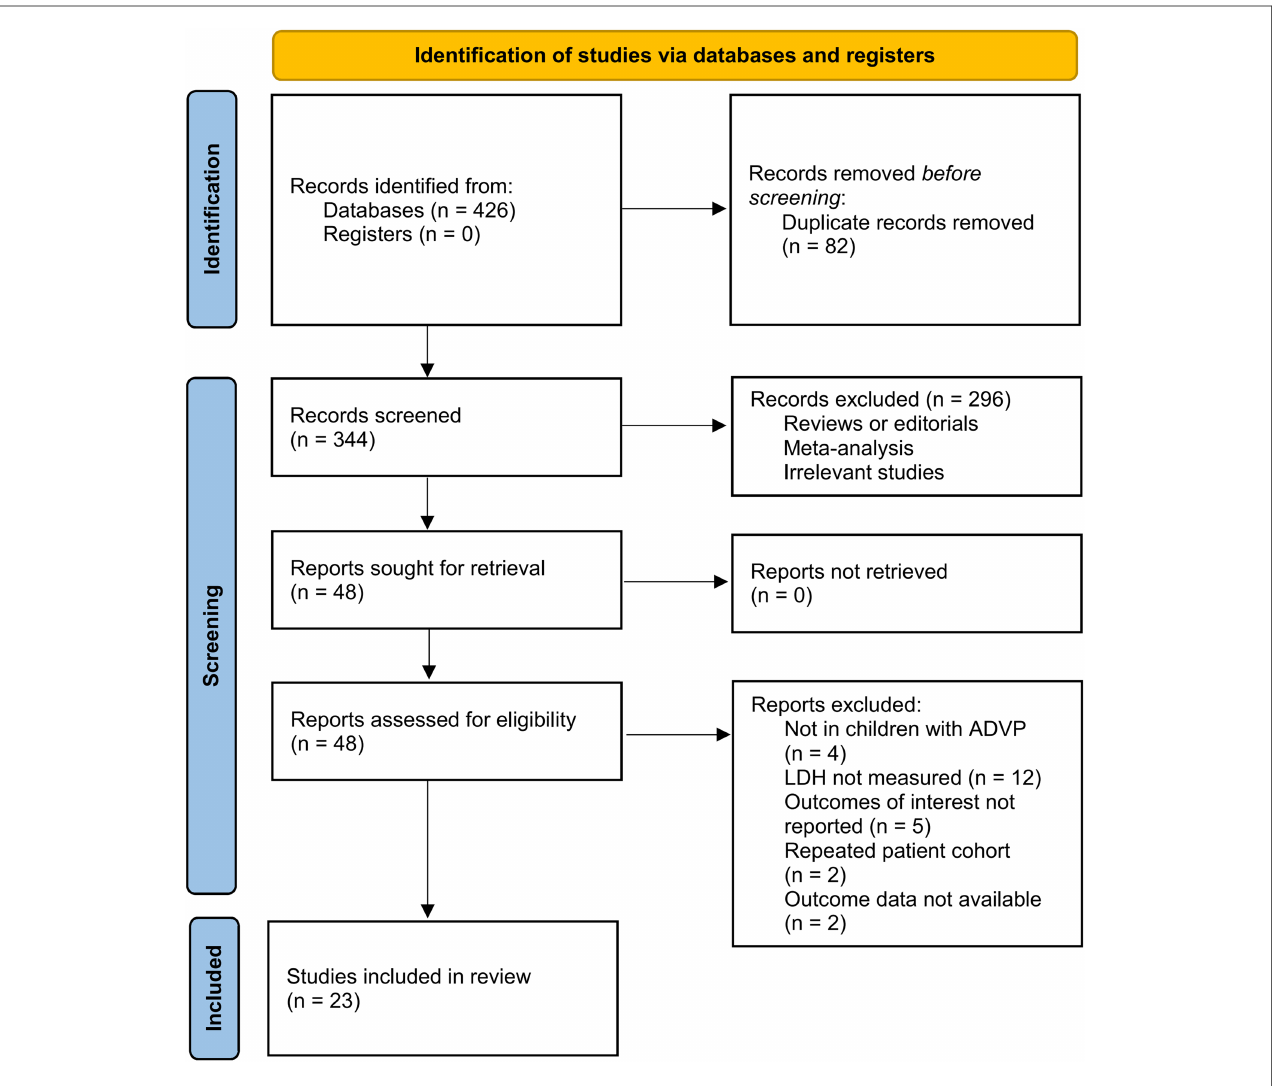
FIGURE 1 Diagram of database search and study